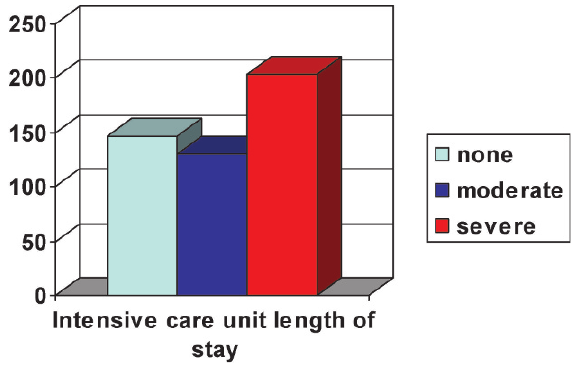
Figure 2 - Total amount of intensive care unit hours distributed according to patient-prosthesis mismatch.